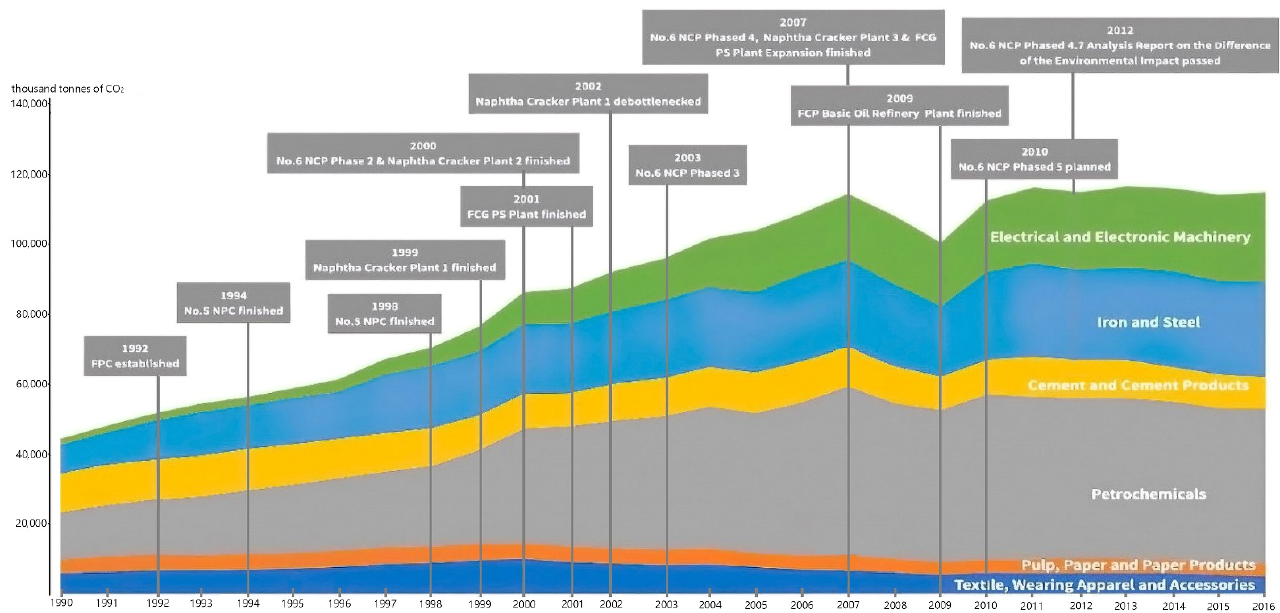
Figure 2. The carbon emission trends in Taiwan during the 1990–2016 period by industrial sector. Source: made by authors.